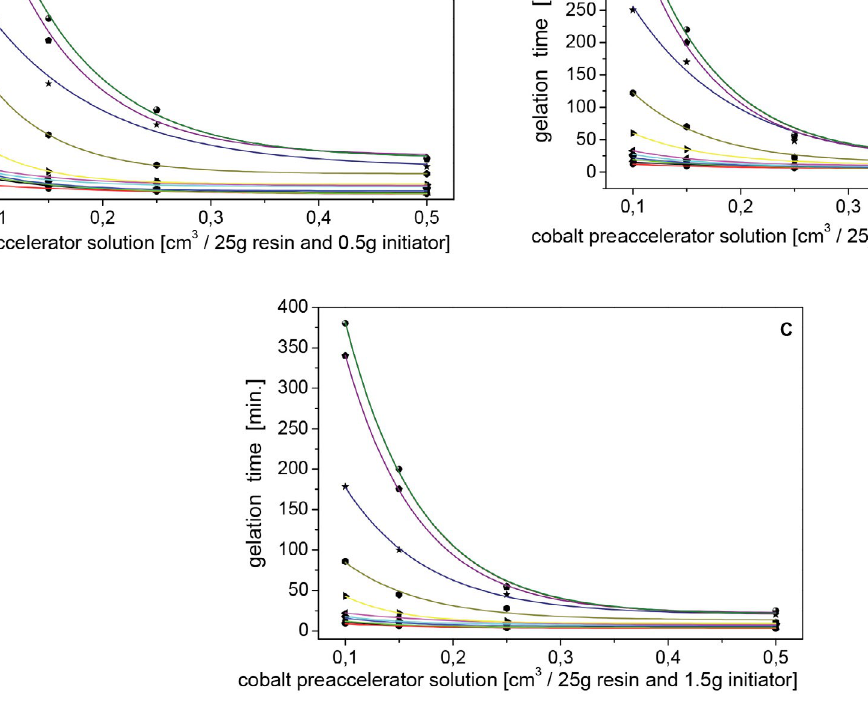
Figure 6. Gelation times of unsaturated polyesters resins with various amount of cobalt accelerator solution and various amounts of chemically incor- porated modifier B. To 25 g of resin, 0.5 g (plot A), 1.0 g (plot B), and 1.5 g (plot C) of butanone peroxide initiator was added; the amounts of chemi- cally incorporated modifier B: ( ■ ), 0.002 wt.-%; ( • ), 0.005 wt.-%; ( ▲ ), 0.010 wt.-%; ( ▼ ), 0.020 wt.-%; ( ◆ ), 0.050 wt.-%; (  ), 0.100 wt.-%; (  ), 0.250 wt.-%; (  ), 0.500 wt.-%; (  ), 0.750 wt.-%; (  ), 1.000 wt.-%; (  ), 1.250 wt.-%, (  ) 1.500